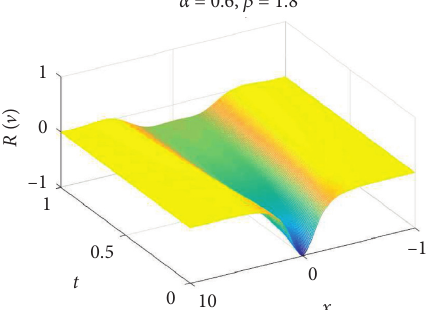
Figure 8: The trace of the solution to the real part of v with α � 0 . 6 and β � 1 . 8.